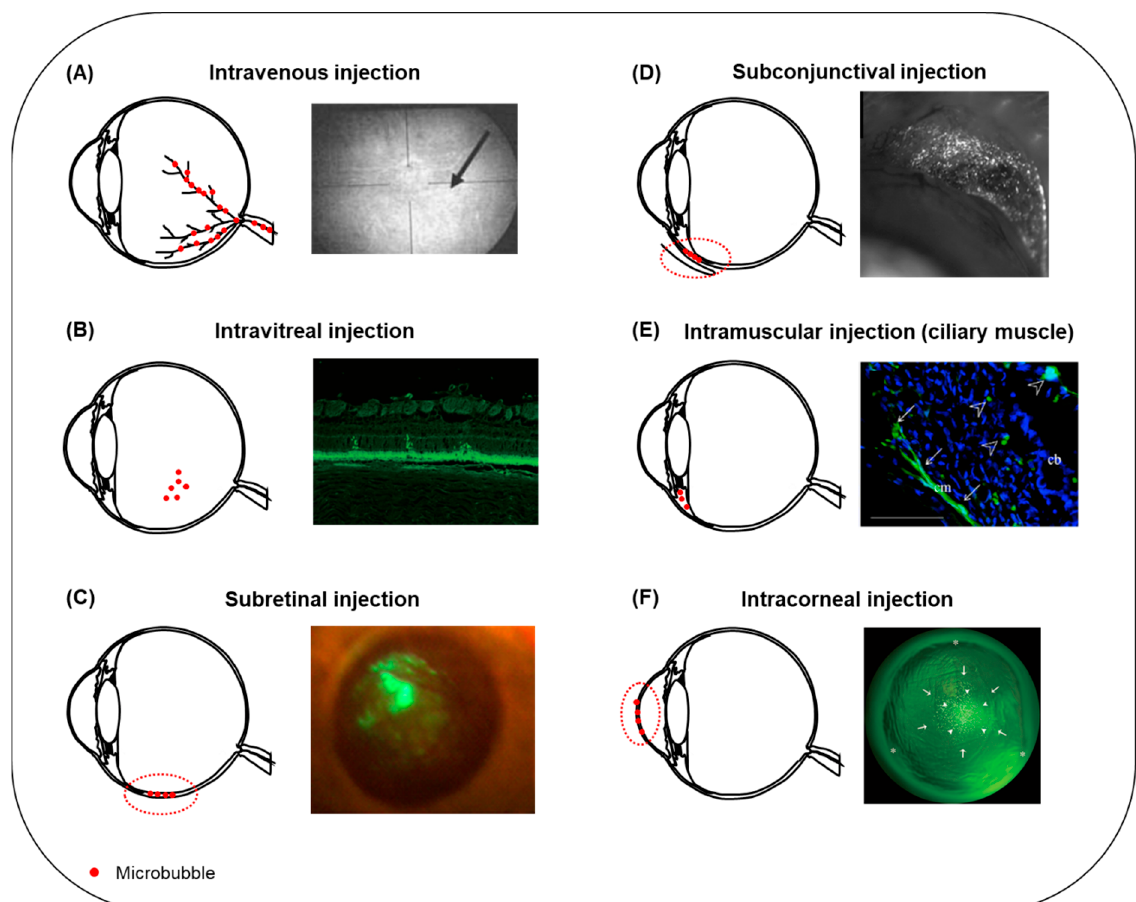
Figure 5. Summary of microbubble injection sites reported in the literature for USMB-mediated ocular drug and gene delivery. ( A ) Following intravenous administration, microbubbles circulate in the retinal blood vessels ( left ). Microbubble oscillations can induce disruption of the BRB and extravasation of fluorescein from blood retinal vessels ( right , arrow). Adapted with permission from [79], John Wiley and Sons, 2007. ( B ) The most frequently encountered administration site for microbubbles in ocular drug delivery is intravitreal injection ( left ). Fluorescence microscopy image of a rabbit retinal section after treatment with bubble liposomes in combination with plasmid GFP and intravitreal ultrasound ( right ). GFP-positive cells were present in the ONL. Adapted from [85] Hindawi, 2012. ( C ) Schematic illustration of microbubbles in- jected into the subretinal space ( left , dashed line). Fluorescent fundus stereoscopic image of rat retina treated with rAAV2- EGFP and USMB ( right ). GFP signal covered a large retinal surface area and was visible for 120 days post-treatment. Adapted from [87], Sciendo, 2009. ( D ) Schematic illustration of subconjunctival injection of microbubbles ( left , dashed line). Expression of GFP on the conjunctiva of a rat 48 h after treatment with plasmid-GFP combined with bubble lipo- somes and ultrasound ( right ). Adapted with permission from [103], Elsevier, 2007. ( E ) Schematic illustration of microbub- bles injected into the ciliary muscle ( left ). Fluorescence microscopy image of a rat eye after combined treatment with pEGFP-C1 gene, intramuscular microbubbles and ultrasound ( right ). GFP-positive cells were localized in the ciliary mus- cle (arrows) and the ciliary body (arrowhead). Adapted with permission from [112], Elsevier, 2011. ( F ) USMB-mediated drug or gene delivery in the cornea can be facilitated upon intracorneal injection of microbubbles ( left , dashed line). Flu- orescence stereomicroscopic image of a rabbit cornea, 7 days post-treatment with plasmid GFP and USMB ( right ). A mix- ture of microbubbles and plasmid was injected into the center of cornea (arrows), and ultrasound treatment was performed with the ultrasound probe positioned on the corneal surface (arrowheads). GFP-positive cells were colocalized with the area where the ultrasound probe was positioned. Adapted with permission from [147], ARVO, 2006. Figure not to scale.